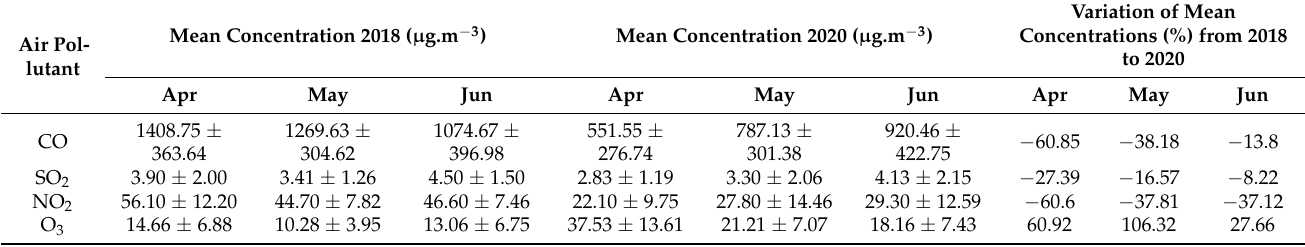
Figure 4. Spatial distribution of CO 2 emissions variation through internal political and territorial divisions (departments). Warm and cold colors indicate an increase and decrease, respectively, in emissions between the March and June 2018 and 2020. Table 2. Mean concentration and standard deviation of CO, SO 2 , NO 2 and O 3 in Bogot á during the lockdown (April to June 2020) compared to the same period in 2018